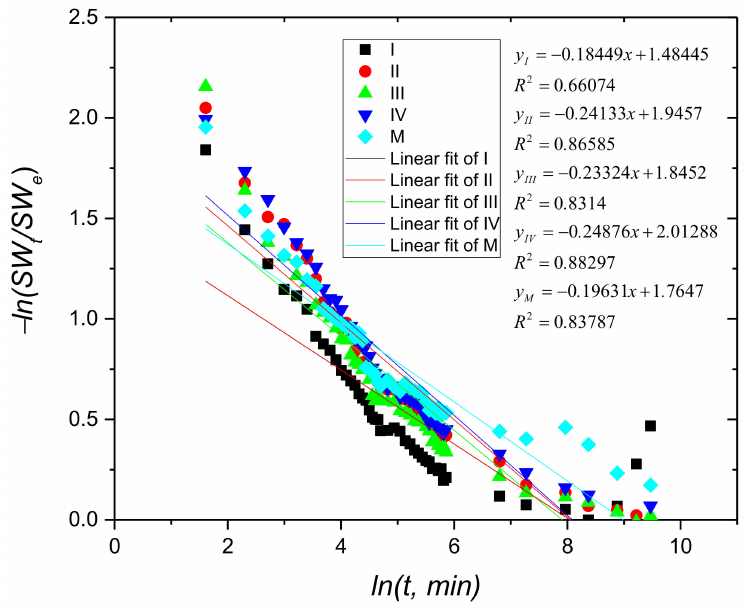
Figure 4. The plot of − ln (SWt/SWe) against ln(t) for samples containing copper and the control sample (M) for the whole swelling process.